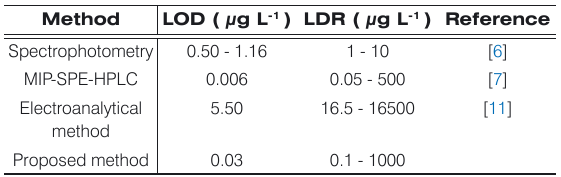
Table 3. Results of real sample analysis. Sample